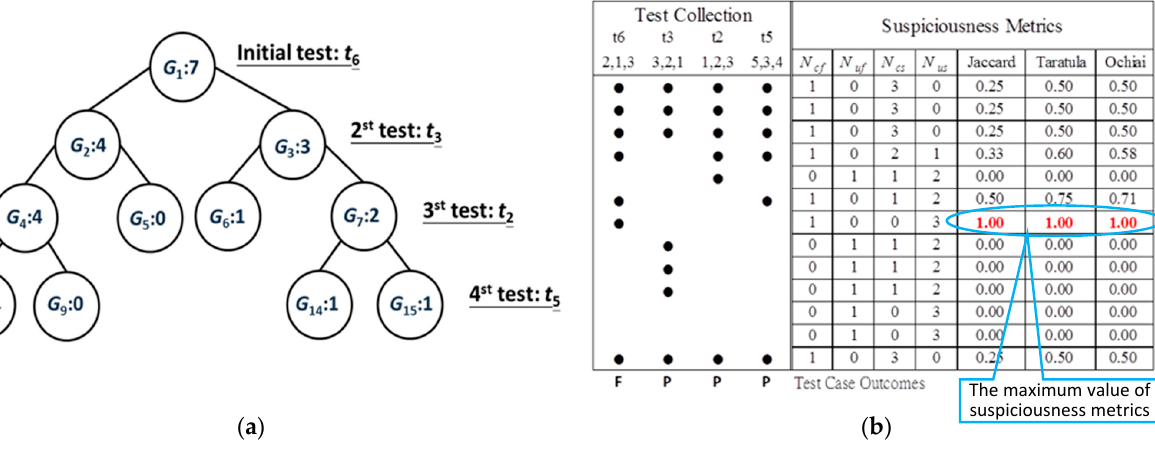
Figure 5. An example program Mid () with ( a ) MADAG tree and ( b ) suspiciousness metrics.